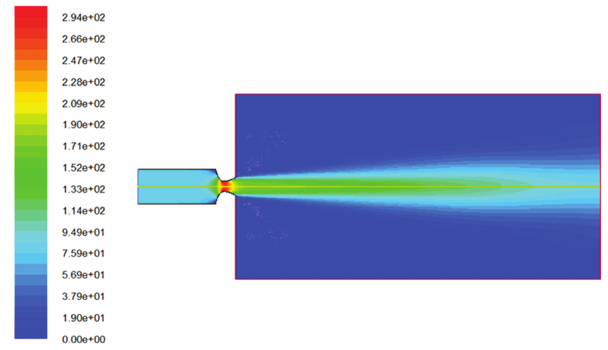
Figure 7: The contours of gas velocity at Mach